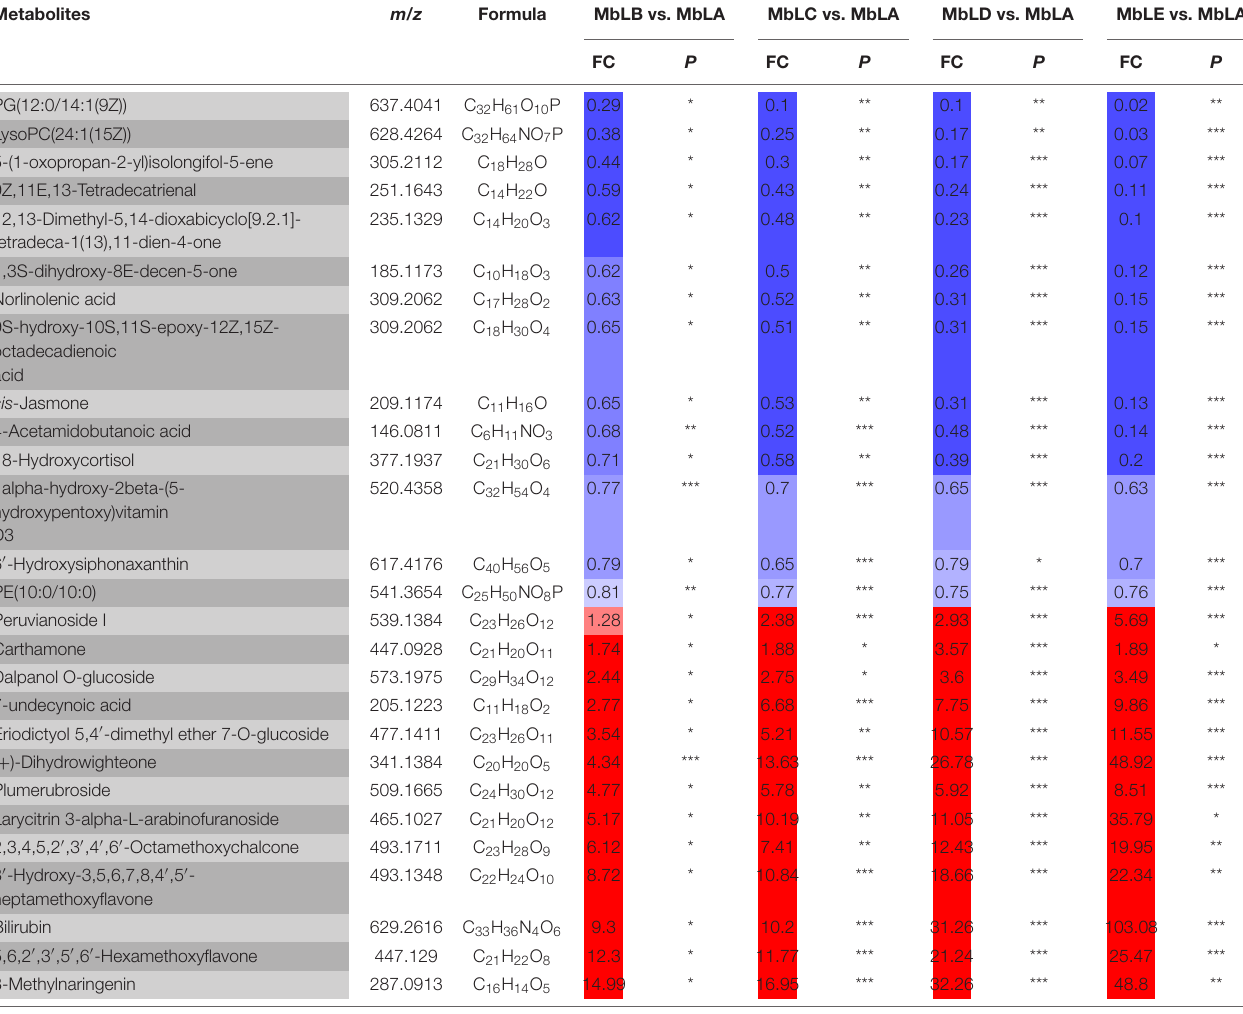
TABLE 1 | Identified the main common differential accumulative metabolites with fold changes in MbLA, MbLB, MbLC, MbLD, and MbLE groups in their p -values of mulberry leaves. Metabolites m/z Formula MbLB vs.